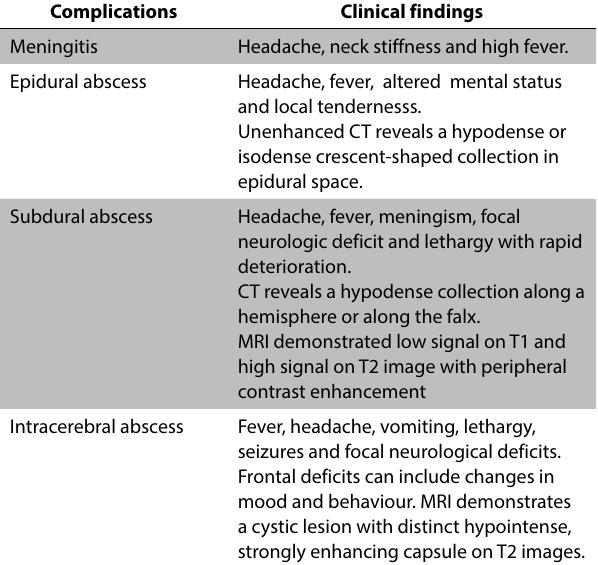
Table II. Complications of acute rhinosinisitis –